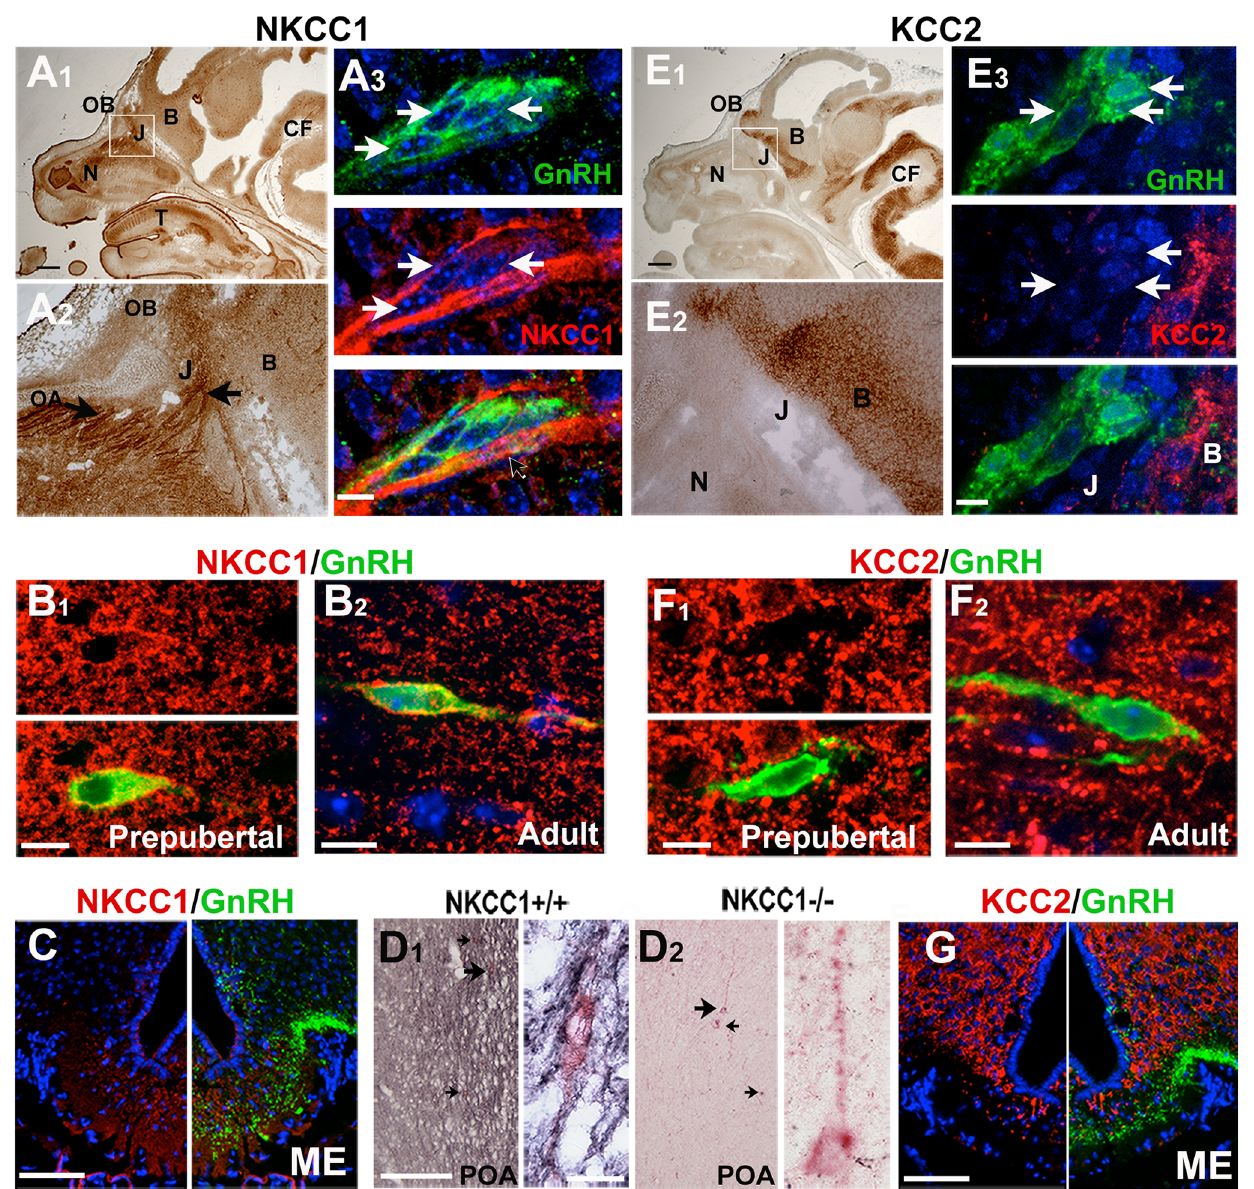
Fig 1. GnRH neurons are positive for NKCC1 and negative for KCC2 throughout development. A1-2) Robust NKCC1 staining (brown) was detected at E14.5 in the nasal area (N) including cells in the olfactory epithelium and cells and fibers (OA, black arrows) at the nasal forebrain junction (J), with many fibers seen entering the developing olfactory bulb (OB). A2 is higher magnification of boxed area in A1. A3) GnRH neurons (green, arrows) in nasal areas were NKCC1 positive (red), showing light labeling over their cell soma (white arrows). Labeling of GnRH processes was obscured by dense labeling of olfactory axon bundles (black arrow). B) NKCC1 (red) is co-localized in GnRH neurons (green) in pre-pubertal (B1) and adult (B2) mice. NKCC1 labeling was more robust in GnRH neurons and surrounding preoptic tissue at pre-pubertal ages compared to adult. However, in the adult, some GnRH neurons remained clearly positive for NKCC1 in the cell soma and proximal processes (B2). C) NKCC1 (red) was present in the median eminence (ME), but did not co-localized with GnRH fibers (green). D) Chromagen double-labeling amplification of NKCC1 signal with NiDAB (blue-black) in sections from WT (D1) and NKCC1 -/- (D2) mice demonstrates ubiquitous NKCC1 staining throughout the pre-optic area (POA) and staining of GnRH neurons (red), both cell soma and processes in WT mice (D1). E1-2) KCC2 staining (brown) was robust in the developing OB, ventral forebrain and areas around the cephalic flexure (CF). E2) Higher magnification of boxed area in E1 showing no KCC2 labeling in nasal areas (N) or at the nasal forebrain junction (J). E3) GnRH cells (green, arrows) at forebrain junction (J) are negative for KCC2 (red), while cells in the ventral forebrain (B) robustly stain for KCC2. F) GnRH cells (green) are KCC2 (red) negative in both pre-pubertal (F1) and adult (F2) mice, although robust KCC2 labeling is found throughout the brain. G) Although present in the median eminence (ME), KCC2 (red) did not co-localize with GnRH fibers (green). F) Double labeling was performed for GnRH neurons with anti-GFP and/or anti- cGnRH. Arrows indicate GnRH cells and large arrow indicate cells magnified on the right. Scale bars: A1 and B2 = 200 μ M, E, F, and G = 100 μ M; A3, B3, C and D = 10 μ M. B = brain; T = tongue. N (cid:1) 3 at all stages.